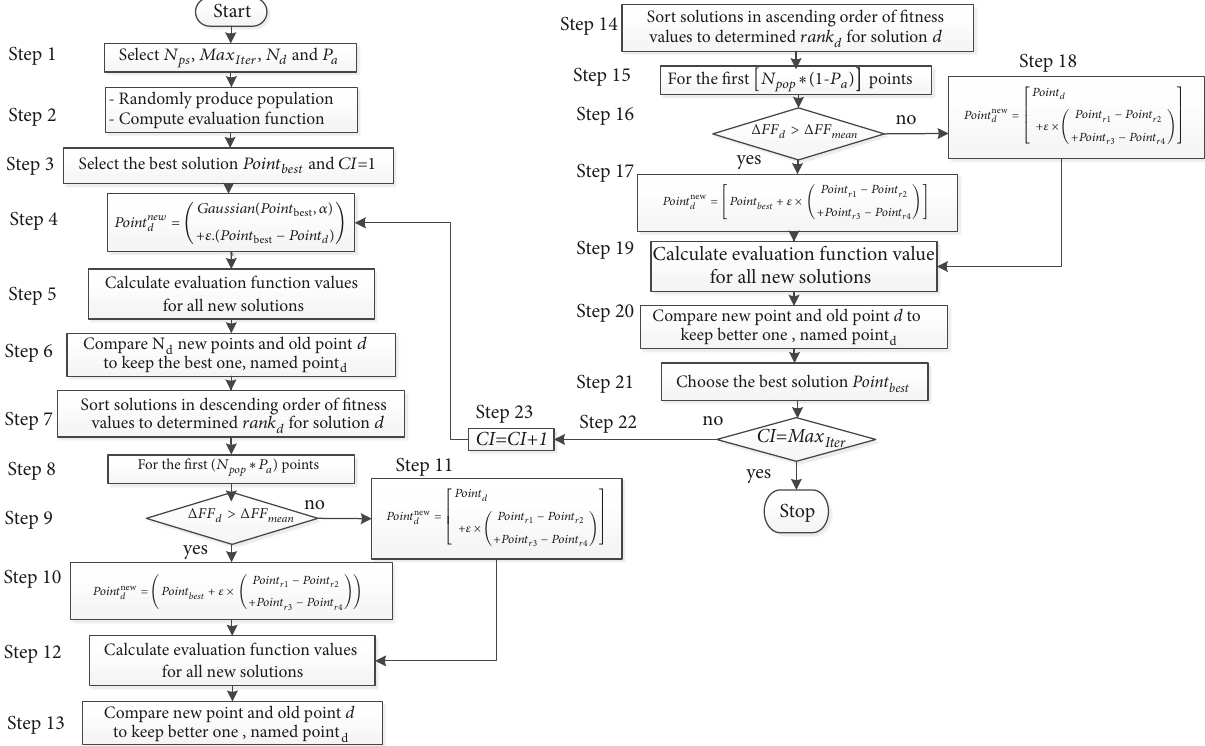
Figure 3: Flowchart of using MSFS for solving a typical optimization